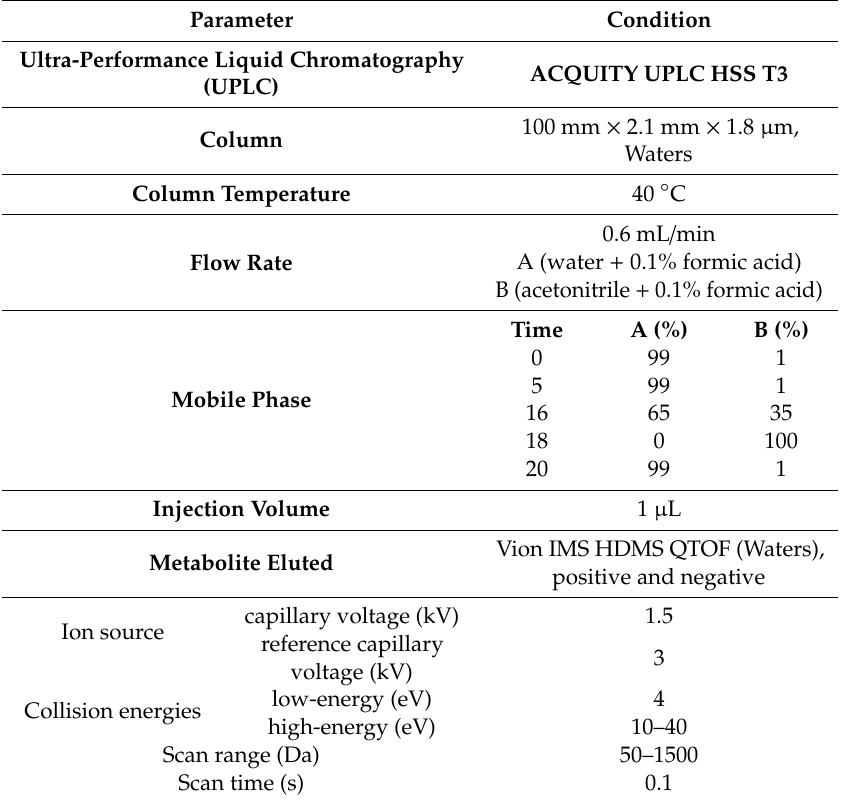
Table 4. LC-MS / MS analysis